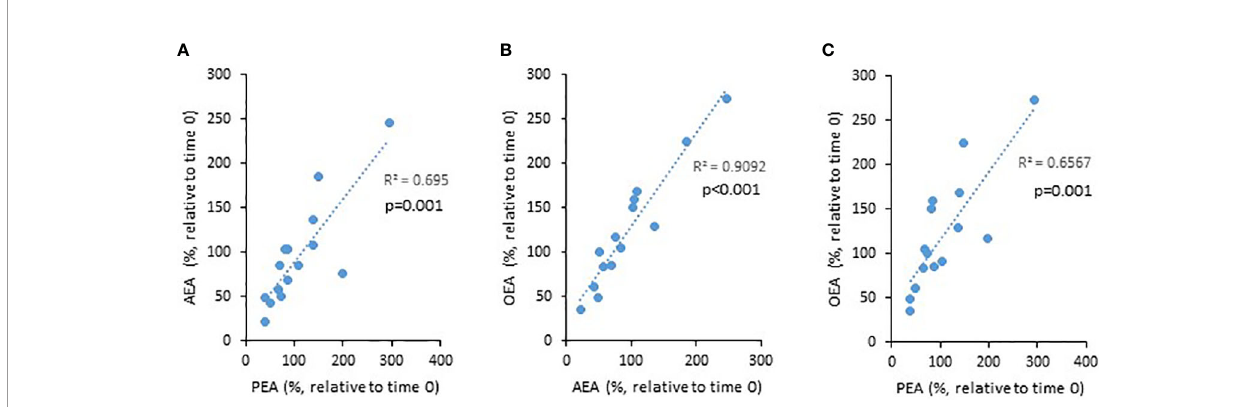
FIGURE 2 | The relationship between the levels of eCBs throughout the 8 weeks trial. UC patients were treated for 8 weeks with cannabis or placebo. eCBs level were evaluated before the beginning of the experiment and 8 weeks later. The graphs describe the changes in eCBs level as a function of the changes in other eCBs level [ (A) PEA vs. AEA, (B) AEA vs. OEA, and (C) PEA